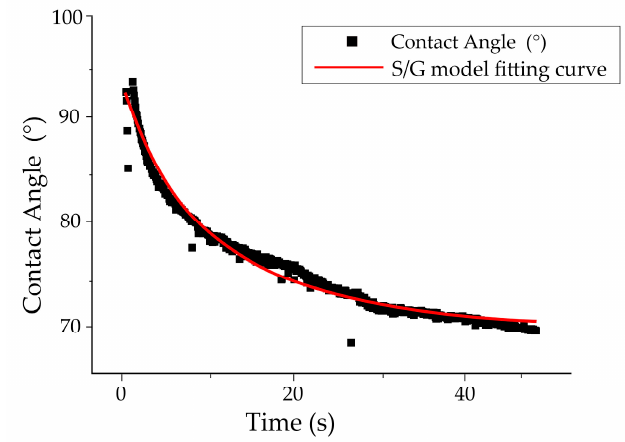
Figure 8. S / G model fitting curve of glycerol contact angle (Sample Figure 8. S/G model fitting curve of glycerol contact angle (Sample 4).